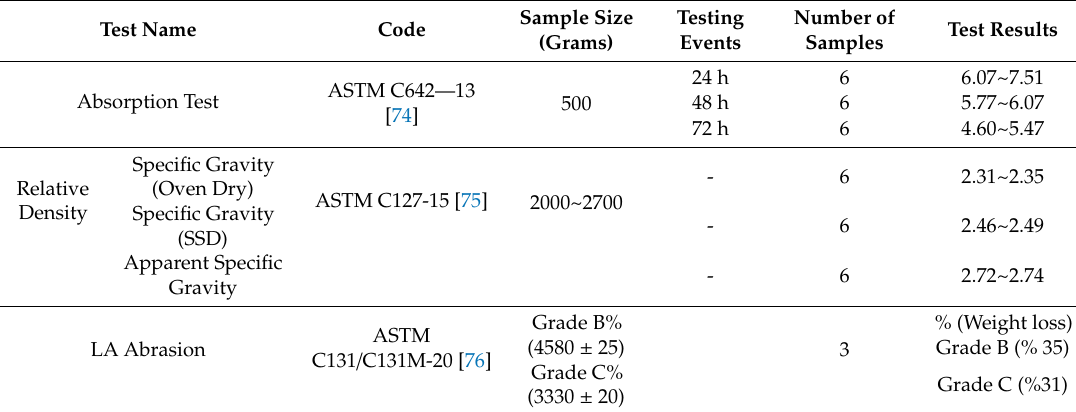
Figure 1. Di ff erent batches of recycled aggregate particles. ( a ) Batch 1 (P1), ( b ) Batch 2 (P2), ( c ) Batch 3 Figure 1. Different batches of recycled aggregate particles. (a) Batch 1 (P1), (b) Batch 2 (P2), (c) Batch (P3), ( d ) Batch 4 (P4). 3 (P3), Batch 4 (P4) . Table 3. Summary of recycled aggregate Table 3. Summary of recycled aggregate properties.